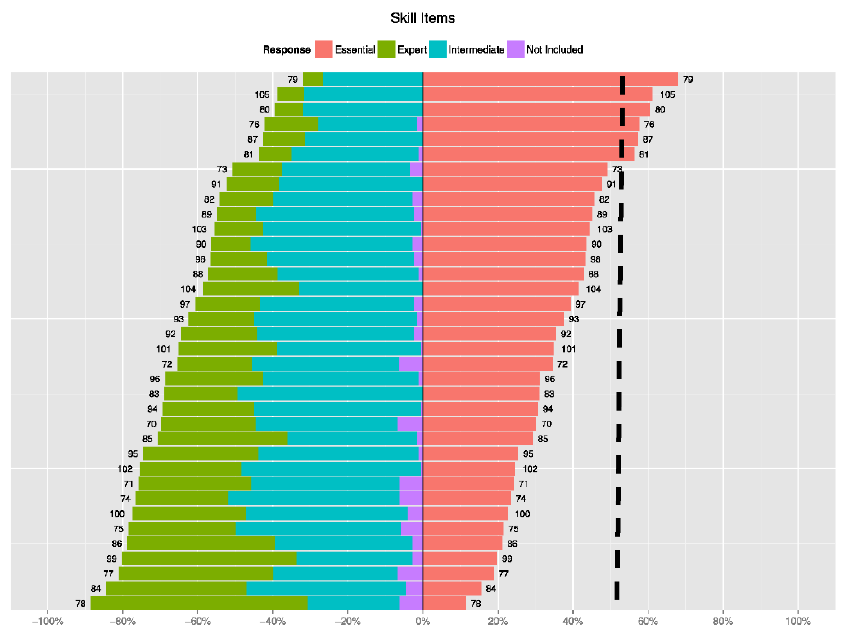
Figure 2. Distribution of the Skill Items.